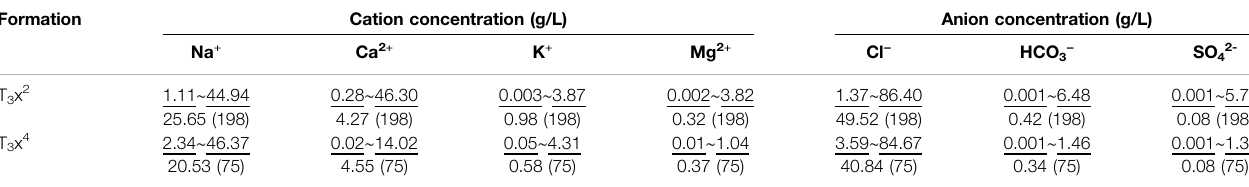
TABLE 1 | Statistics of the main ion content in the formation water of the Xujiahe Formation. Formation Cation concentration (g/L)